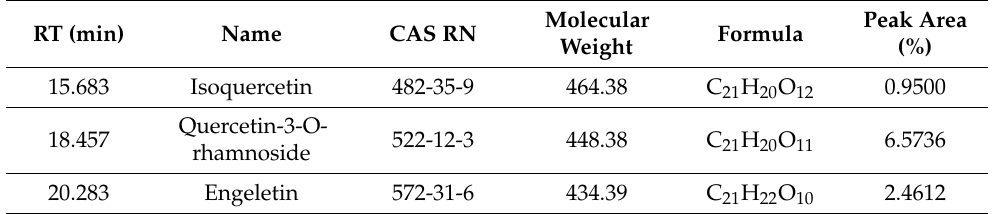
Figure 5. HPLC chromatograms by comparison with the standards. Table 2. The single crystal in the EtOAc fraction .